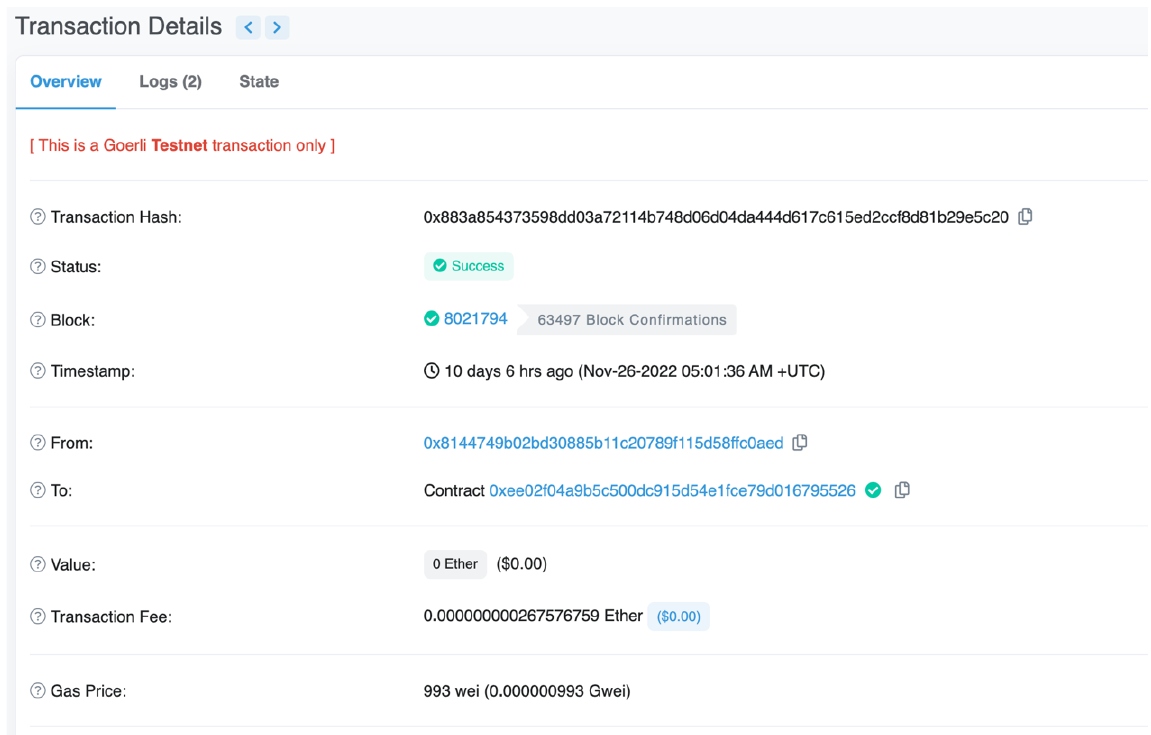
Figure A11. Proof of issuing funding request on Etherscan.